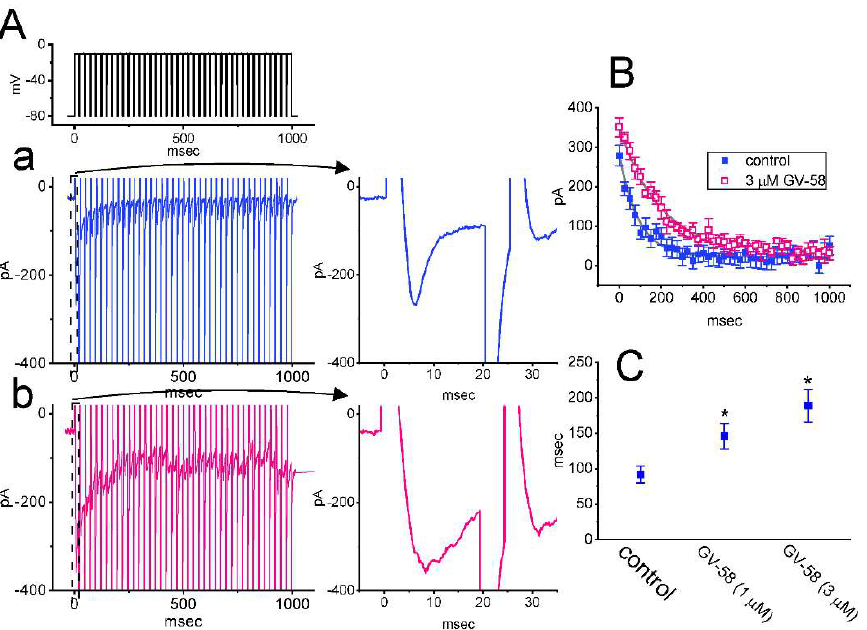
Figure 5. Effect of GV − 58 on current decline induced during a 40 Hz train of depolarizing pulses. The train was designed to consist of 40 20 ms pulses separated by 5 ms intervals at −80 mV with a duration of 1 s. ( A ) Representative current traces obtained in the control period (a) and during cell exposure to 3 μM GV − 58 (b). The voltage − clamp protocol is illustrated in the uppermost part. To provide single I Na trace, the right side of (A) denotes the expanded records from the dashed box of ( Aa ) and ( Ab ). ( B ) The relationship of peak I Na versus the train duration in the absence (filled blue symbols) and presence (filled red symbols) of 3 μM GV − 58 (mean ± SEM; n = 7 for each point). The continuous smooth lines over which the data points are overlaid are well fitted by single exponential. Of note, the presence of GV − 58 can slow the time course of current inactivation in response to a train of depolarizing pulses. ( C ) Summary graph showing effect of GV − 58 (1 and 3 μM) on the time constant of current decay in response to a train of depolarizing command voltage from −80 to −10 mV (mean ± SEM; n = 7 for each bar). Current amplitude was measured at the beginning of each depolarizing pulse. Of notice, the presence of GV-58 produces an increase in the time constant in the decline of peak I Na activated by a train of pulses. * Significantly different from control ( p < 0.05).